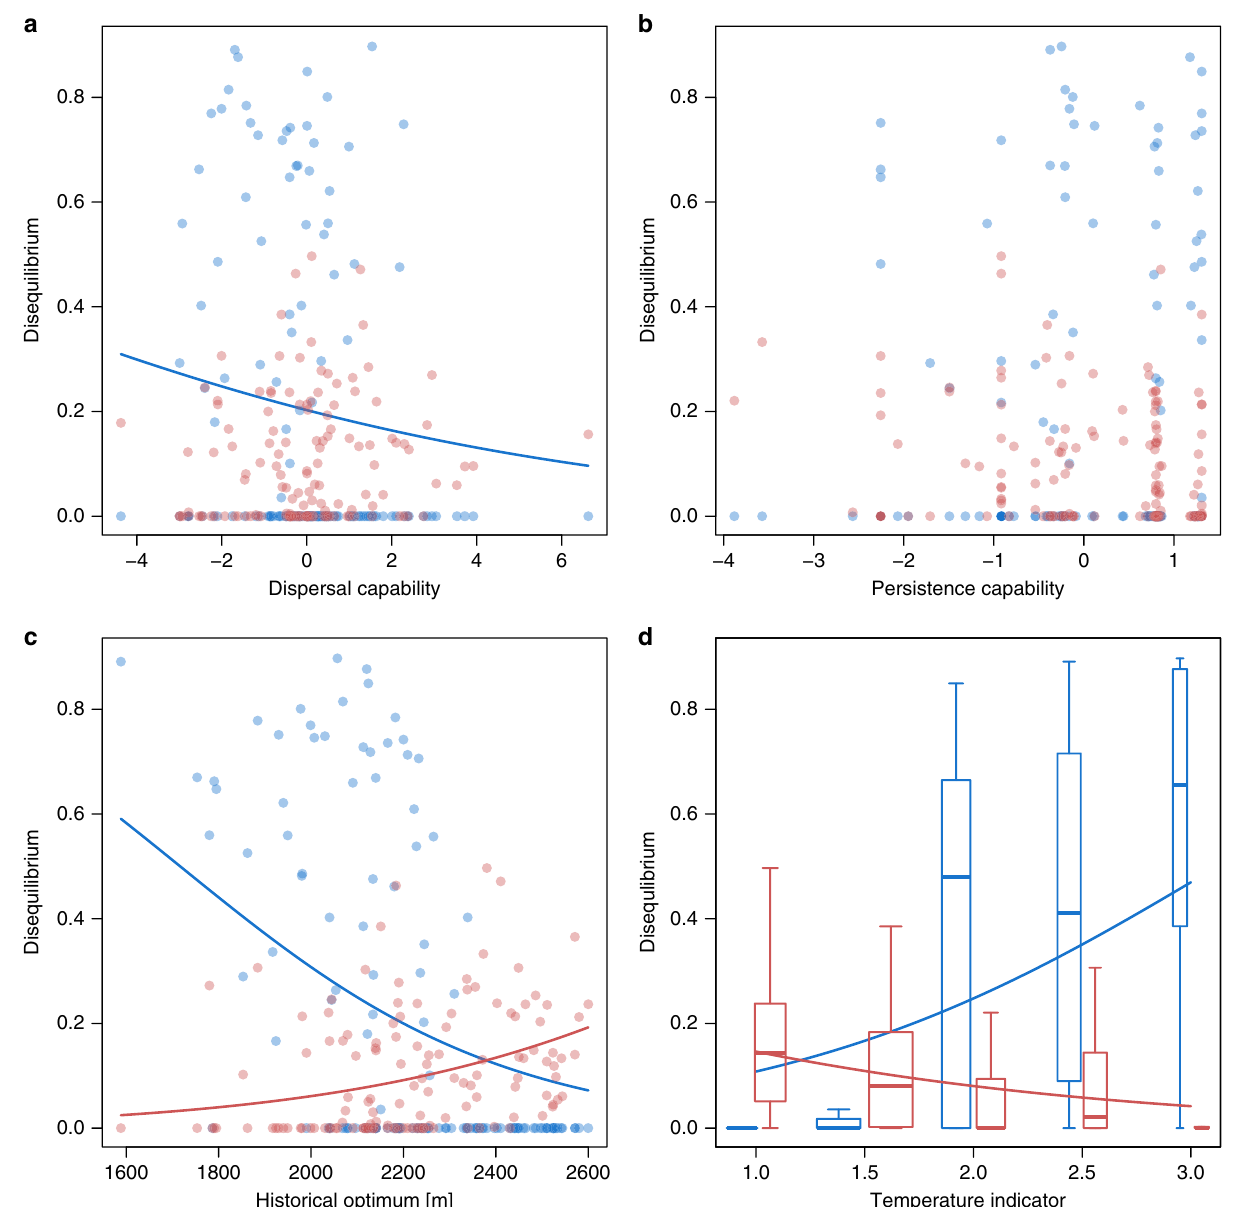
Fig. 3 Relationships of ecological disequilibria with species-speci fi c properties. Values of extinction debts (red) and colonization credits (blue) are relative to expected extinction and colonization events, respectively (see Methods section). Dots and boxplots represent species and are darker and wider with more species at the same position, respectively. The center line, bounds of box, and whiskers of the boxplots are de fi ned as median, fi rst and third quartile, and 1.5 times the interquartile range, respectively. Signi fi cant back-transformed model estimates are depicted as lines and con fi dence intervals are therefore not shown to improve clarity (see Supplementary Table 1 for coef fi cients, and Methods section for details). For dispersal capability ( a ) high values represent higher dispersal capability of species by wind and animals ( n = 134 species), and for persistence capability ( b ) high values represent competitive, long-living and dominant species ( n = 134 species). Historical optimum ( c ) was calculated as the median elevation of all plots where a species had been recorded in the historical data ( n = 135 species). Temperature indicators ( d ) represent alpine to nival (1), lower alpine to upper subalpine (1.5), subalpine (2), lower subalpine to upper montane (2.5), and montane (3) species ( n = 130 species). Source data are provided as a Source Data fi